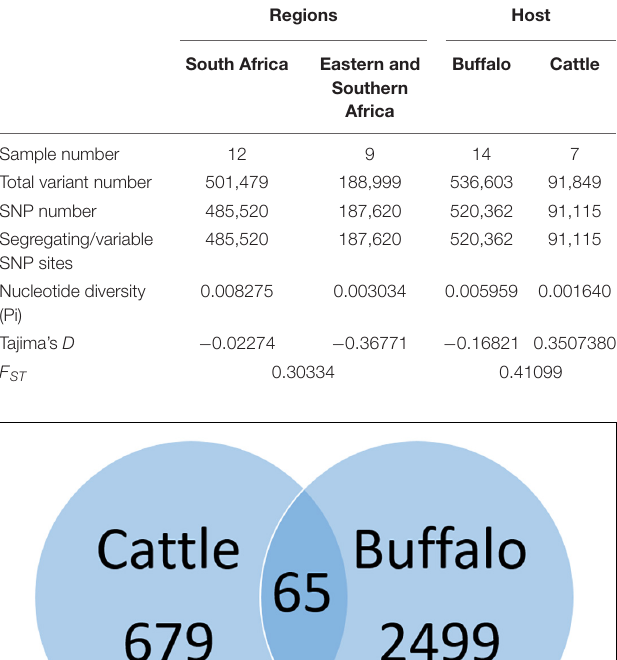
TABLE 6 | Genetic diversity of all joint T. parva strains.